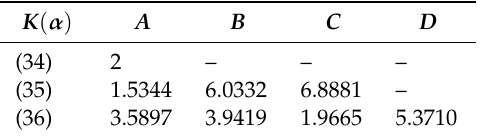
Table 1. The values of the approximation